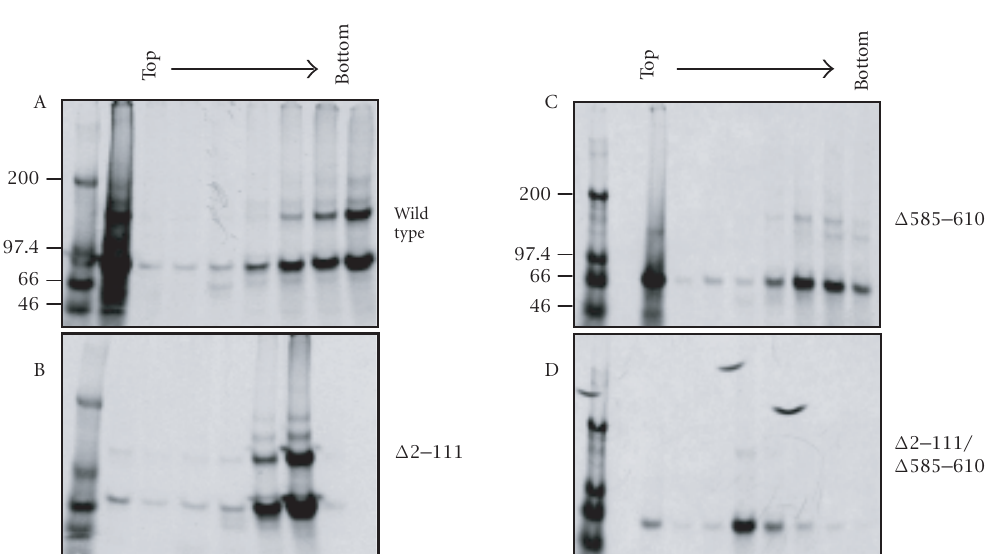
Figure 4: Coupled transcription-translation reactions were carried out for the in vitro synthesis of wild type or mutant ORF 2 proteins. The reactionmixtureswereseparatedonasucrosegradient,thefractionsimmunoprecipitatedandanalyzedonnonreducing 7 . 5 %polyacrylamide gels. Molecular size markers are shown in kilodaltons.